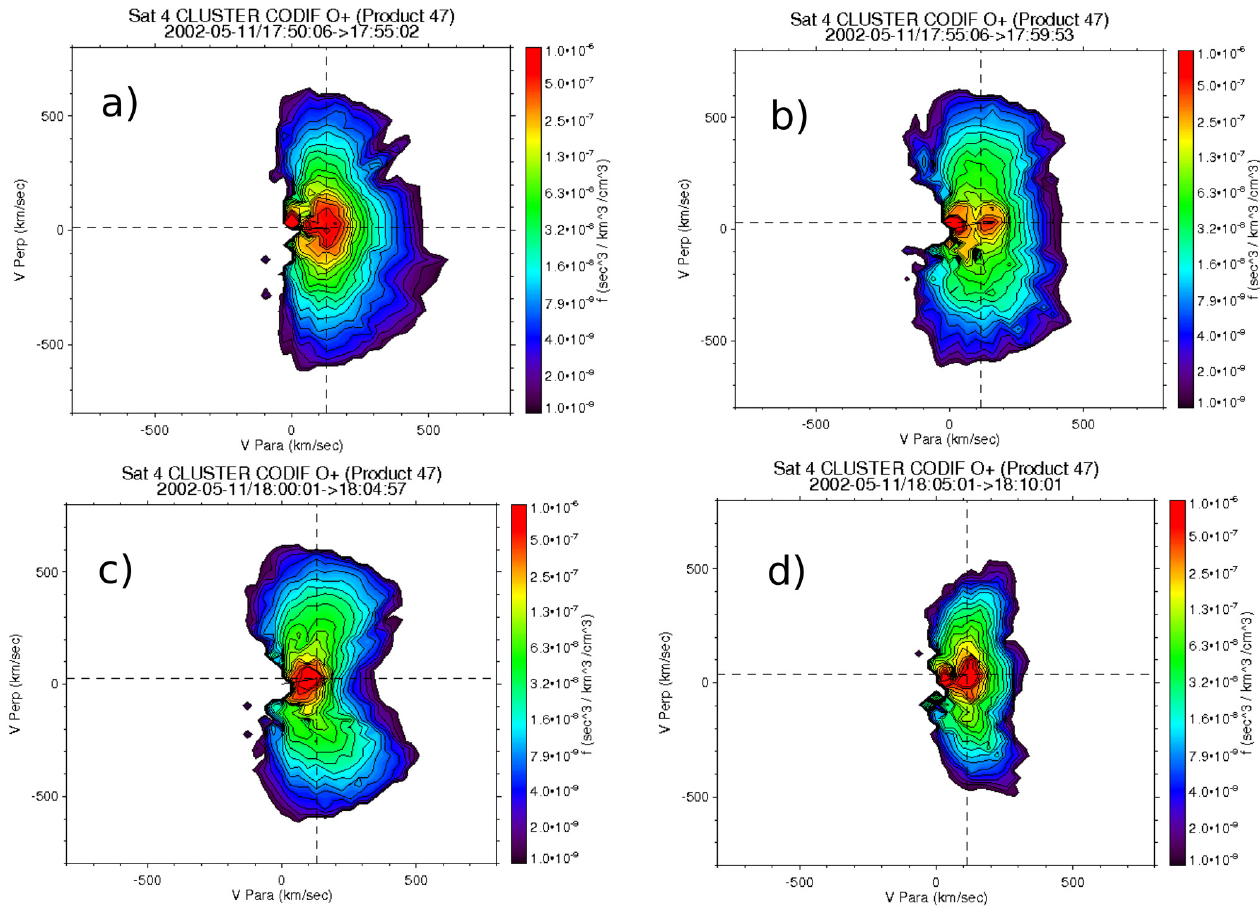
Fig. 2. Distribution functions of O + ions obtained during the event 11 May 2002 in a region of ion heating between, (a) 17:50 and 17:55, (b) 17:55 and 18:00, (c) 18:00 and 18:05, (d) 18:05 and 18:10.